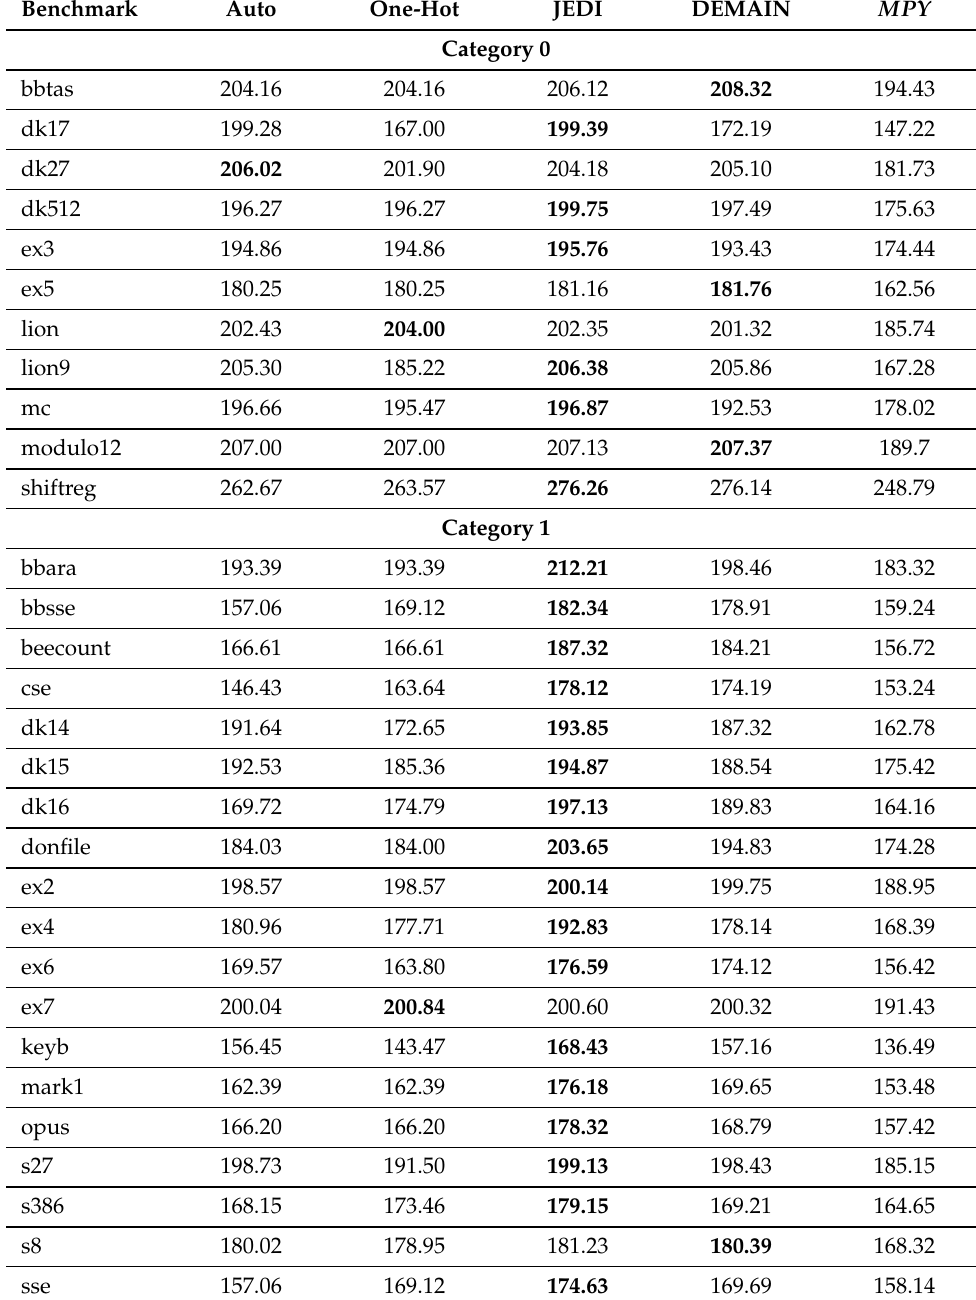
Table 12. Experimental results for MPY Mealy FSMs [123] (the operating frequency,